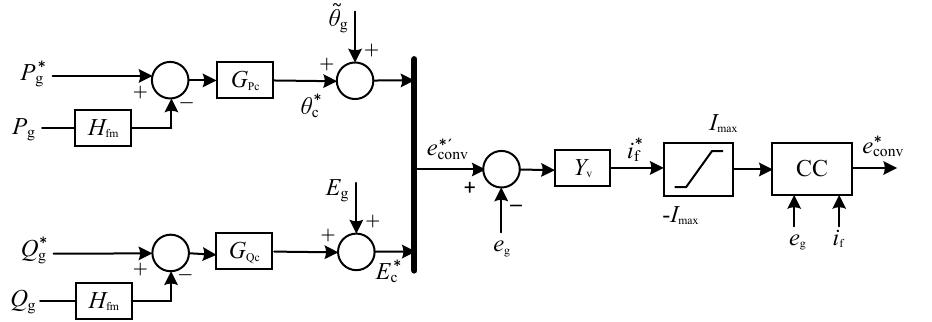
Figure 2. Block diagram of the implemented grid-forming